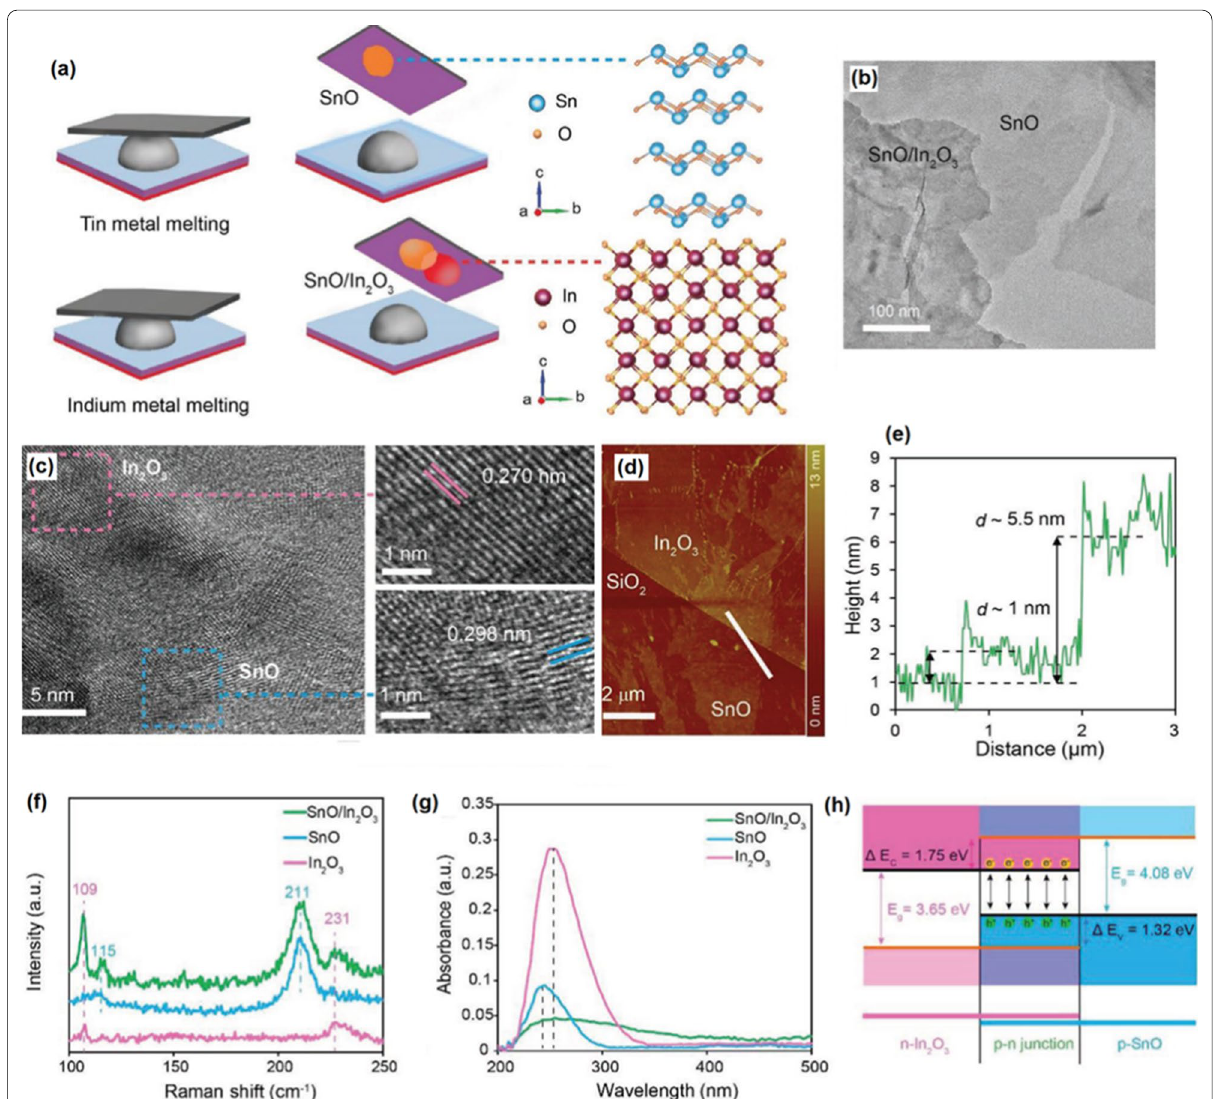
Fig. 13 a Schematic illustration of fabrication of 2D vdW heterostructured SnO/In 2 O 3 film. b The HRTEM image of heterostructured SnO/In 2 O 3 films. c The HRTEM image of atomic structure of heterostructured films show the high crystalline structure of SnO and In 2 O 3 film with their lattice spacing distance. d The AFM of heterostructured SnO/In 2 O 3 film with e the profile thickness of the films. f The Raman spectra of SnO, In 2 O 3 and SnO/ In 2 O 3 2D films. g The optical absorption of SnO, In 2 O 3 and SnO/ In 2 O 3 2D films. h The band alignment of SnO/ In 2 O 3 2D heterostructures. Reprinted with permission from